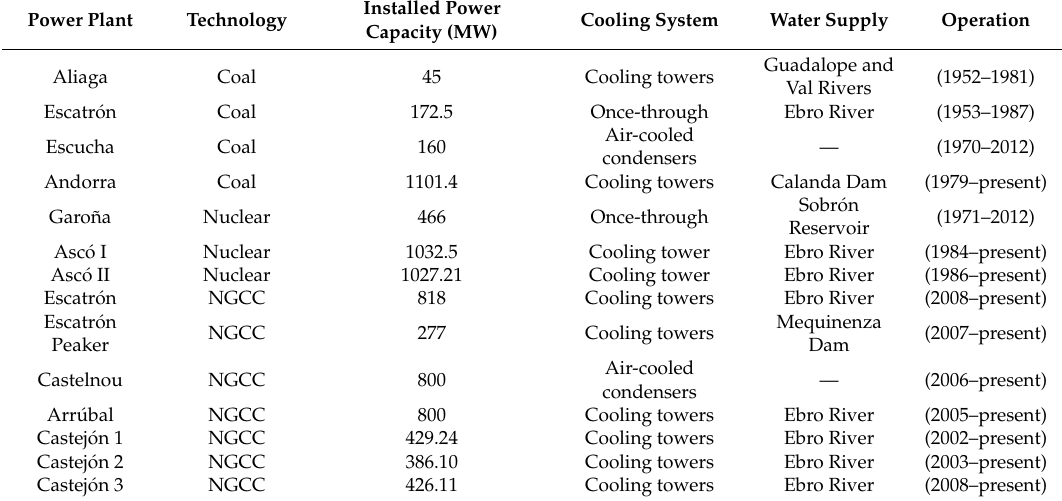
Table 1. Classification of thermoelectric power plants located in the Ebro River basin by type of technology and cooling system.